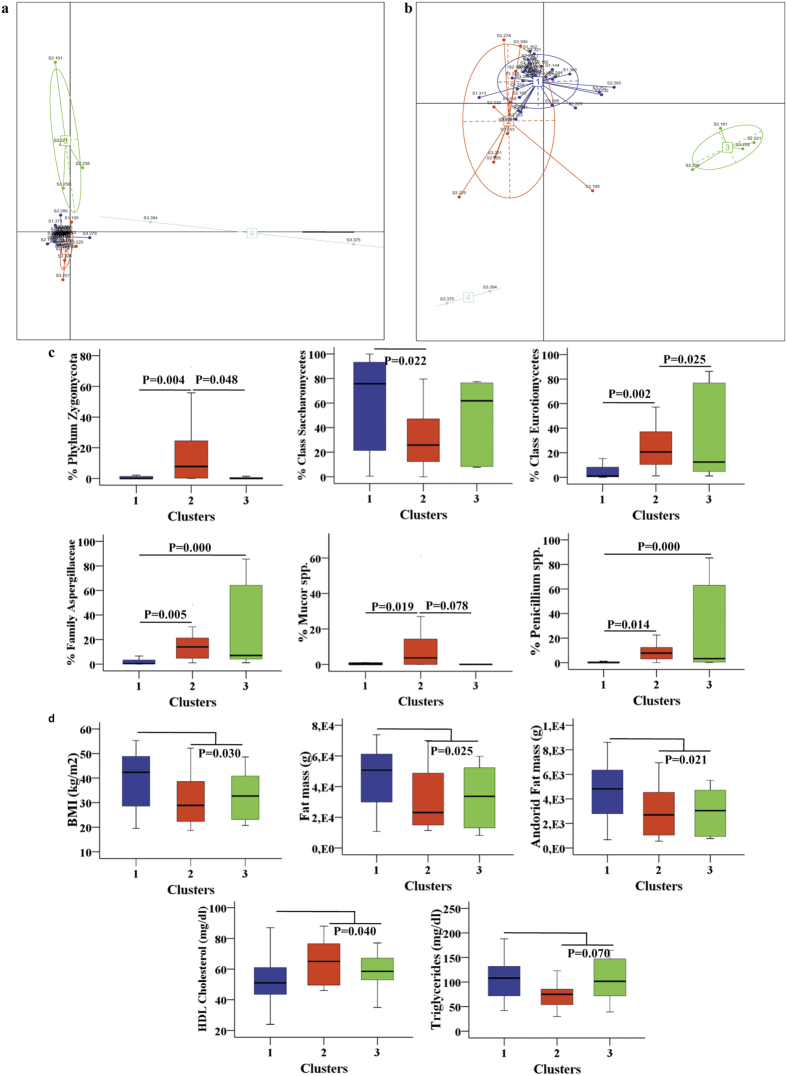
Phylogenetic and metabolic differences between clusters (a) Class analyses and (b), Cluster of patients based on fungi genus identified by pyrosequencing-based ITS- sequences using Principal Coordinate Analyses (PCA) (c), Abundance of the main contributors of each cluster. The coloured scale blox plot, blue, red and green represents cluster 1, 2 and 3 respectively. (d) Cluster associations with clinical and anthropometrical data (body fat and lipid profile). BMI: Body mass index, HDL-cholesterol: high-density lipoprotein.